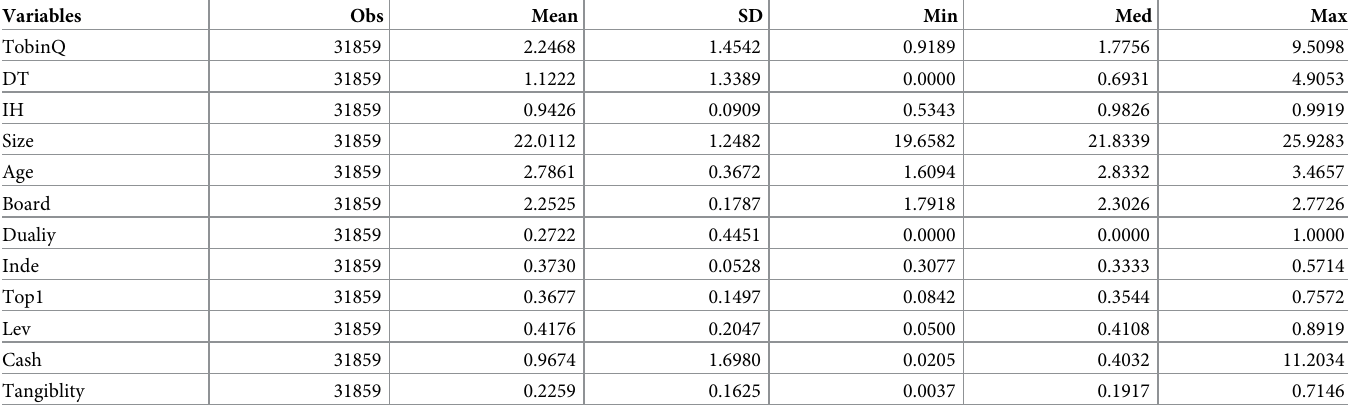
Table 8. Descriptive